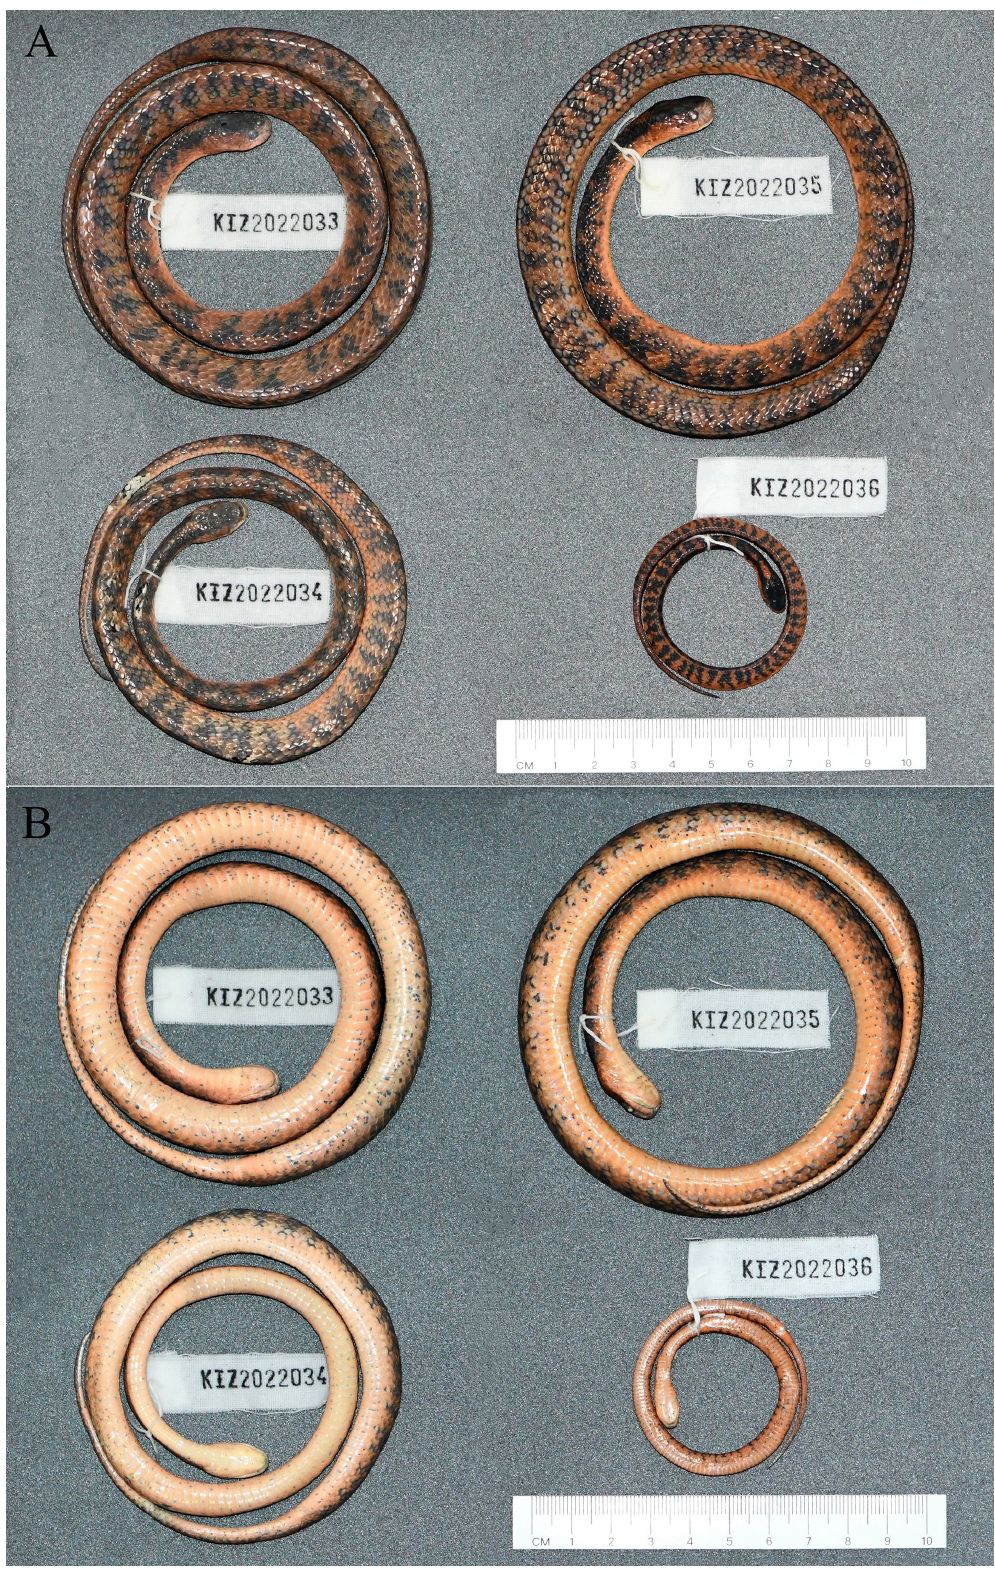
Fig. 3. Pareas yunnanensis (Vogt, 1922), specimens from its type locality in preservative. A . Dorsal views. B . Ventral views. Photos by S.